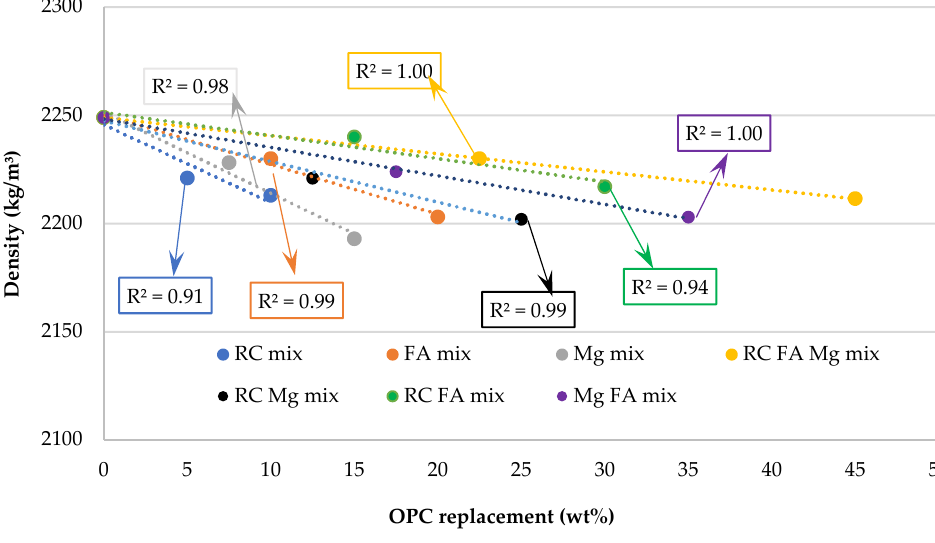
Figure 1. Density versus OPC replacement in the Figure 1 . Density versus OPC replacement in the mixes.